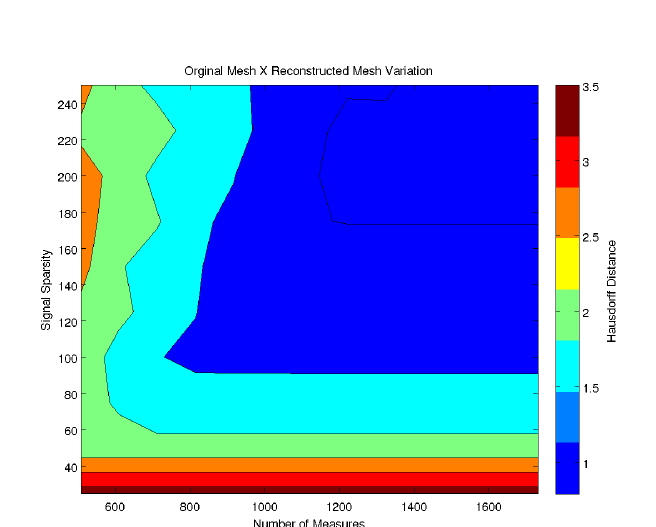
Figure 5: David’s head (Hausdorff Distance between the original mesh and the reconstructed mesh): Gaussian measurement matrix. The average processing time for reconstruction was 27.2517 seconds.